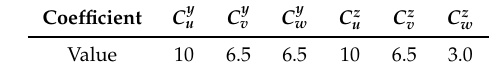
Table 4. Decay coefficients provided by the Handbook N400 [9] for the coherence model in Equation (14). Coefficient C y